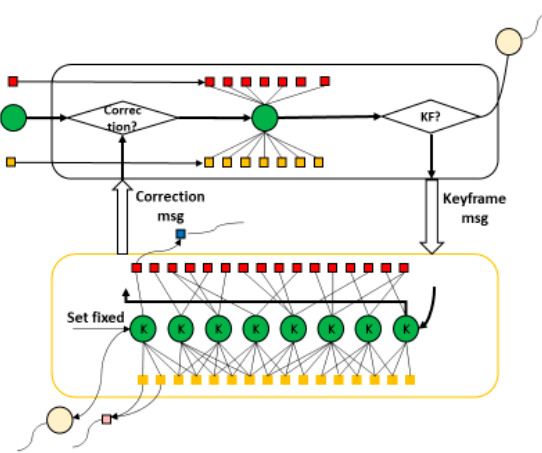
Figure 5. Data communication between tracking thread and local mapping thread.